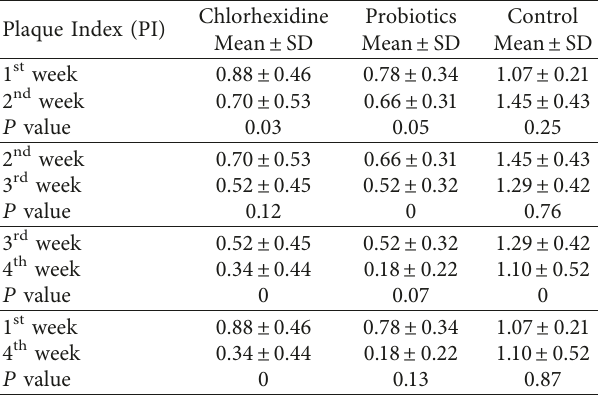
Table 1: Comparison of the mean plaque value scores between the groups. Plaque Index